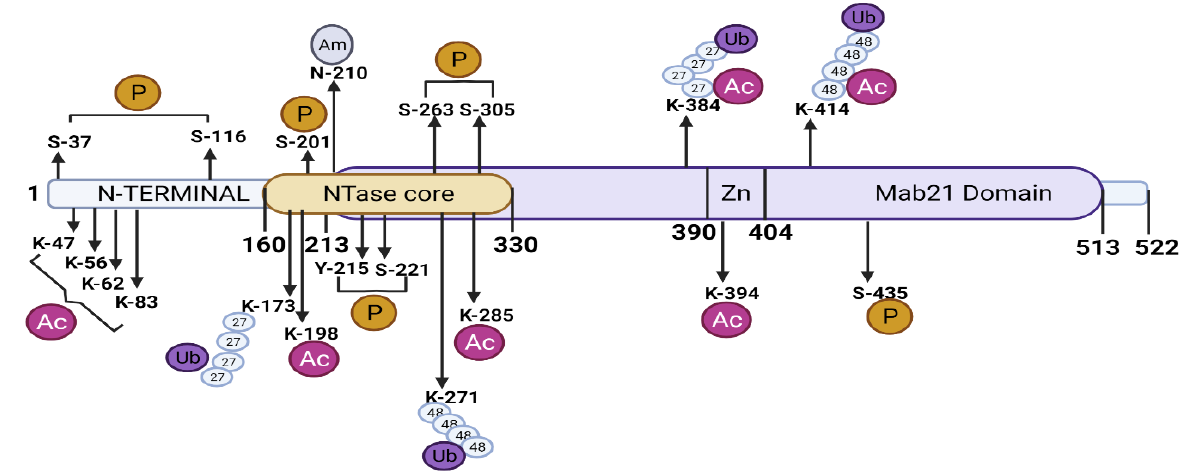
Figure 3. Post-translational regulation of cGAS. cGAS is regulated by various posttranslational modifications in response to dsDNA. The major post-translational modifications in the cells are monoubiquitination, polyubiquitination, phosphorylation, acetylation, and deamidation. This figure illustrates major post-translational modifications occurring on cGAS